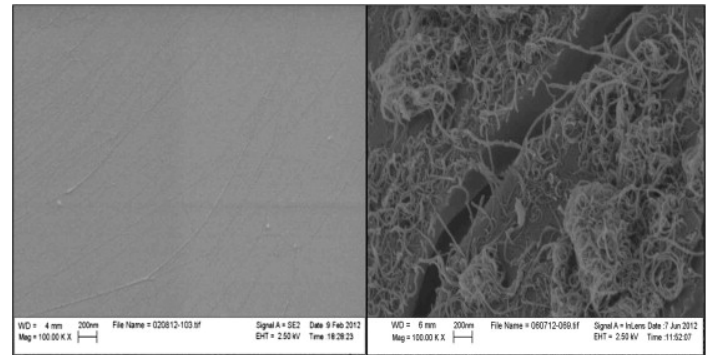
Figure 2. Impact of UV light on a CNT/epoxy nanocomposite: the initial flat surface (left) gets cracks and unprotected CNTs are forming a layer (right). Reprinted from Science